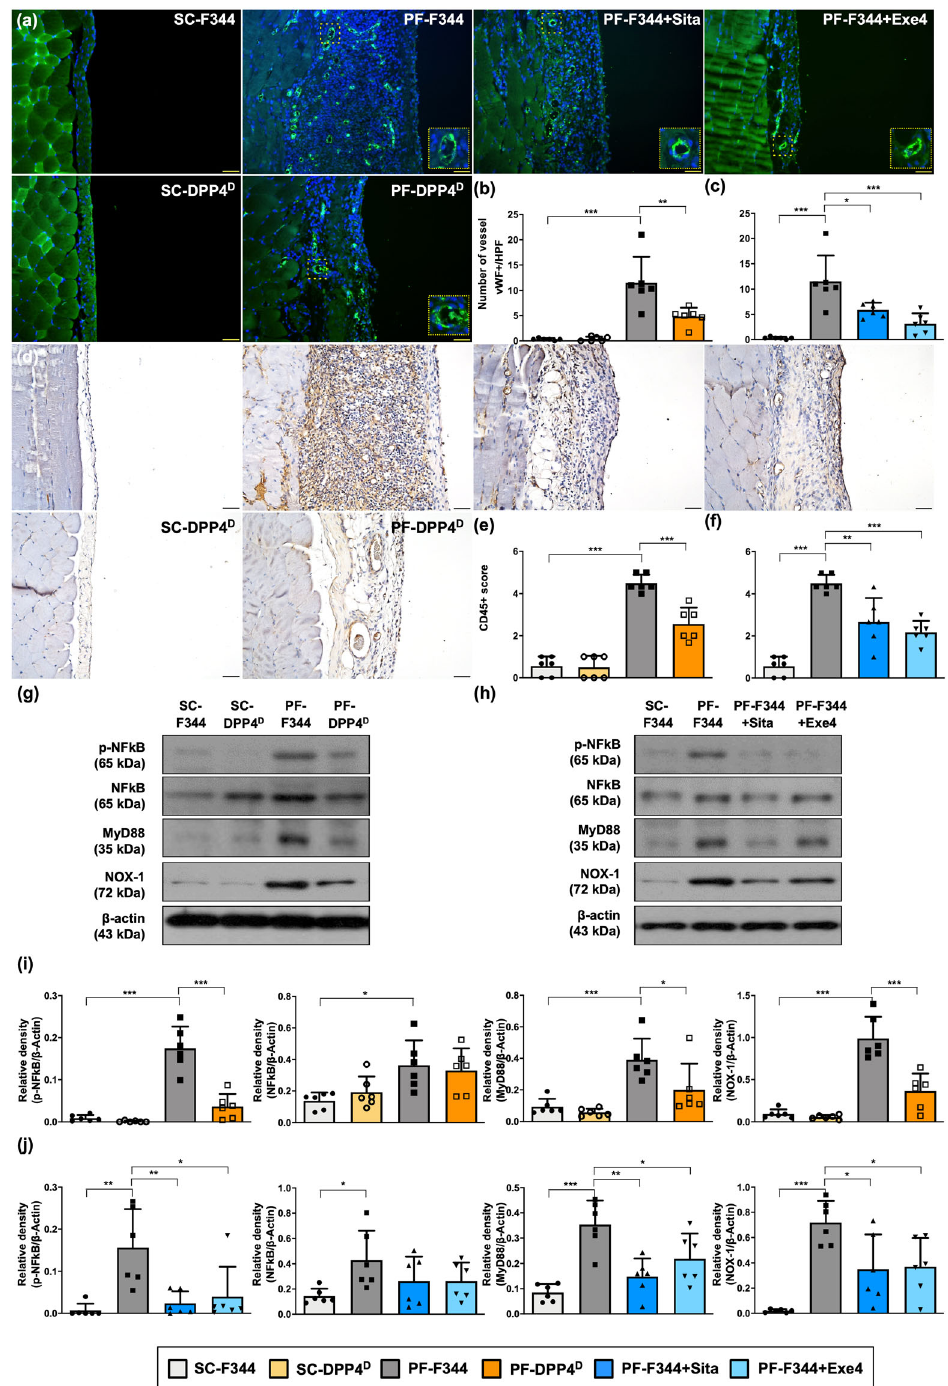
Fig. 6 DPP4 de fi ciency, sitagliptin, and exendin-4 ameliorated CG-inducing angiogenesis and in fl ammation by suppressing NF- κ B/MyD88 signaling in rats. a Representative images of vessels in peritoneal tissue on day 21 were detected by immuno fl uorescent staining (200×) in each group. The blood vessels were indicated by round vWF positive signal (green color). DAPI labels cellular nuclei (blue color). Scale bars: 50 μ m. b , c Quantitative number of vessels as vWF + per high-power fi eld (HPF) in each group. d Illustrating images (200×) of each group for identi fi cation of positively stained CD45 (brown color) as the leukocyte marker by immunohistology staining in peritoneal tissue after CG-inducing PF on day 21. Scale bars: 50 μ m. e , f Quantitative of CD45 + score in each group. g , h Western blotting was performed to detect the protein levels of p-NF-kB, NF-kB, MyD88, and NOX-1 in the peritoneal tissues of each group. i , j Quantitative results of Fig. 6g and Fig. 6h were shown, respectively. n = 6 for each group. Data represents mean ± SD; * indicates p -value <0.05; ** represents p -value <0.01; and *** is p -value